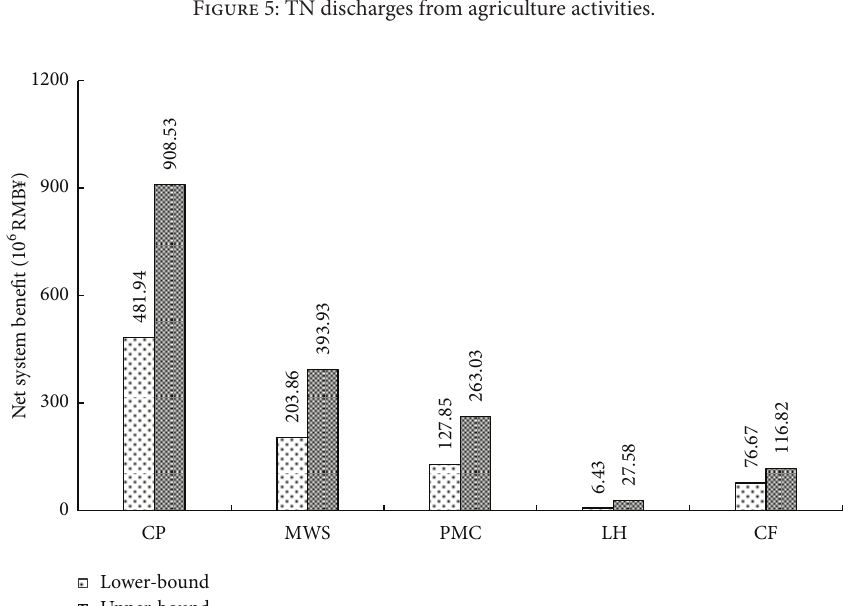
Figure 5: TN discharges from agriculture activities.